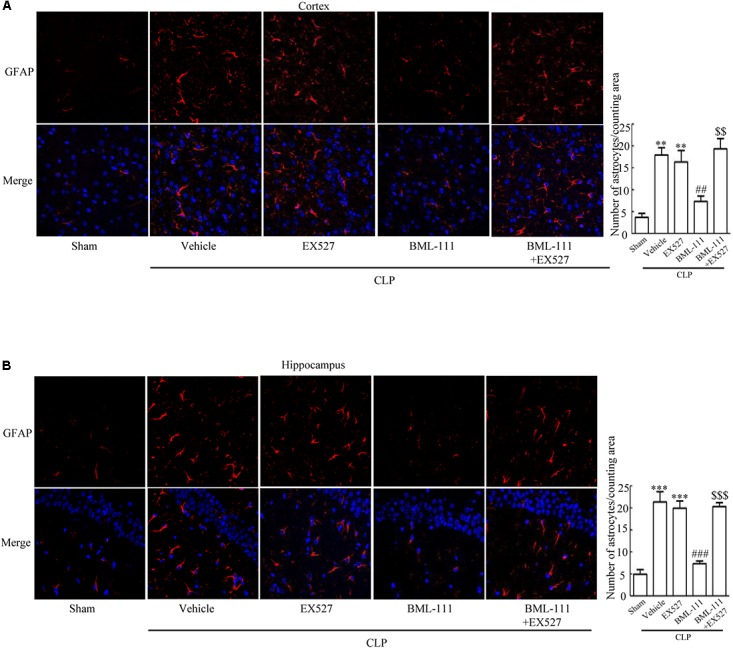
BML-111 decreases the activation of astrocyte induced via SIRT1 in CLP. (A,B) CLP and EX527 increased the activated astrocyte when compared with sham group, and there did not differ between CLP + Vehicle group and CLP + EX527 group. BML-111 decreased the activated astrocyte related to CLP + Vehicle group. EX527 administration before CLP and BML-111 increased the activation of astrocyte compared with the CLP + BML-111 group. Scale bars indicate 50 μm (n = 3 surviving mice per group). ∗∗P < 0.01, ∗∗∗P < 0.001 represent CLP + Vehicle vs. Sham and CLP + EX527 vs. sham, ##P < 0.01, ###P < 0.001 represent CLP + BML-111 vs. CLP + Vehicle,$$P < 0.01, $$$P < 0.001 represent CLP + BML-111 + EX527 vs. CLP+BML-111.